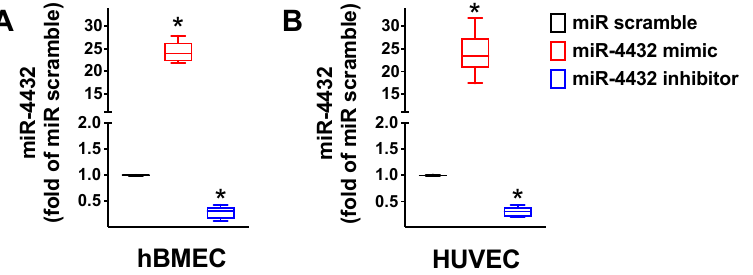
Figure 3. RT-qPCR showing that miR-4432 is expressed in both hBMECs ( A ) and HUVECs ( B ). All the assays were carried out in quadruplicate; the graphs indicate the median and the 5th to 95th percentiles; *: p < 0.01 vs. miR-scramble.